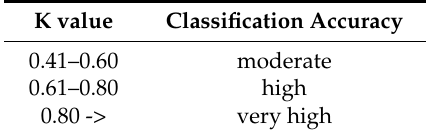
Table 4. Classification accuracy based on the kappa coefficient (K